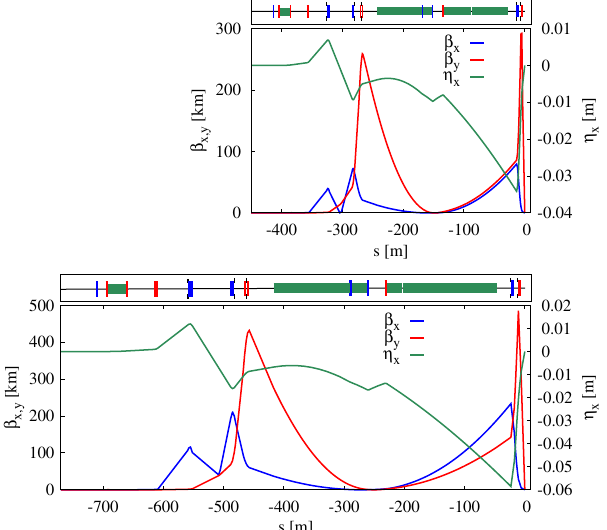
FIG. 5. Optical functions through the local correction scheme of the FFS for L (cid:1) ¼ 3 . 5 m (top plot) and L (cid:1) ¼ 6 m (bottom plot), where η x is the dispersion function. The lattice for L (cid:1) ¼ 6 m has been lengthened with respect to the increase of L (cid:1) from the nominal design.